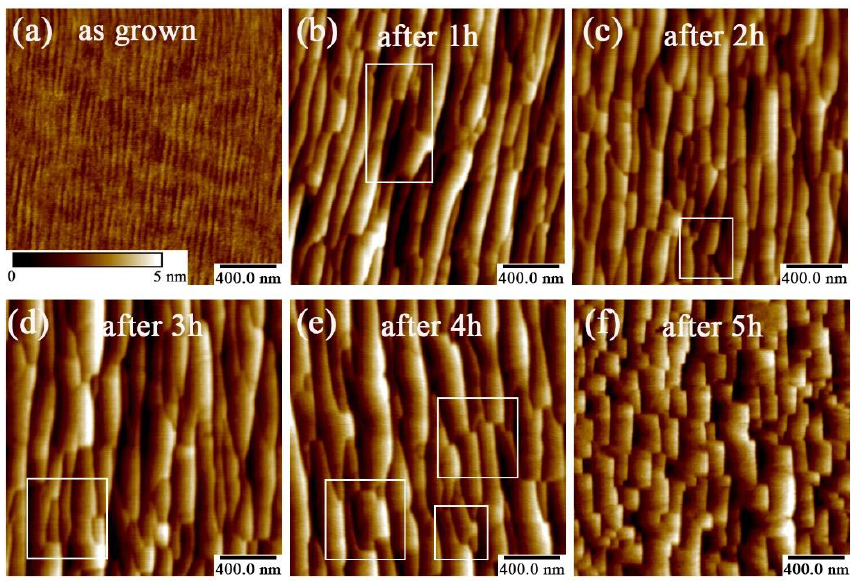
Figure 9. The AFM images of ( a ) as-grown and annealed AlN templates under ( b ) 1 h, ( c ) 2 h, ( d ) 3 h, ( e ) 4 h, and ( f ) 5 h. The AlN thickness is 500 nm.